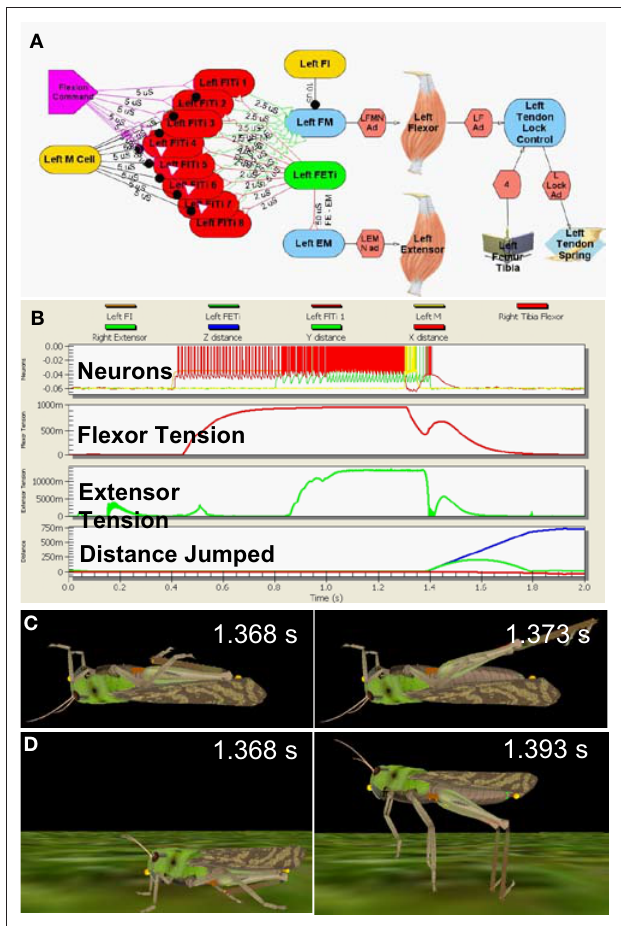
Figure 2 | Simulated locust kick and jump. (A) Neural circuit, with flexor (red) and extensor (green) motor neurons, inhibitory (gold) neurons, flexor command (lavender) neuron, the flexor and extensor muscles, and the tendon lock mechanism that prevents premature extension. (B) Jump motor program. Top: flexor (red), extensor (green), and inhibitory motor neurons (gold); 2nd: Flexor muscle tension; 3rd: Extensor muscle tension; Bottom: longitudinal (blue) and vertical (green) distance moved. (C) The kick immediately before (left) and 5 ms later (right). (D) The jump immediately before (left) and 25 ms later (right) as the feet leave the ground. Adapted from Cofer et al.,